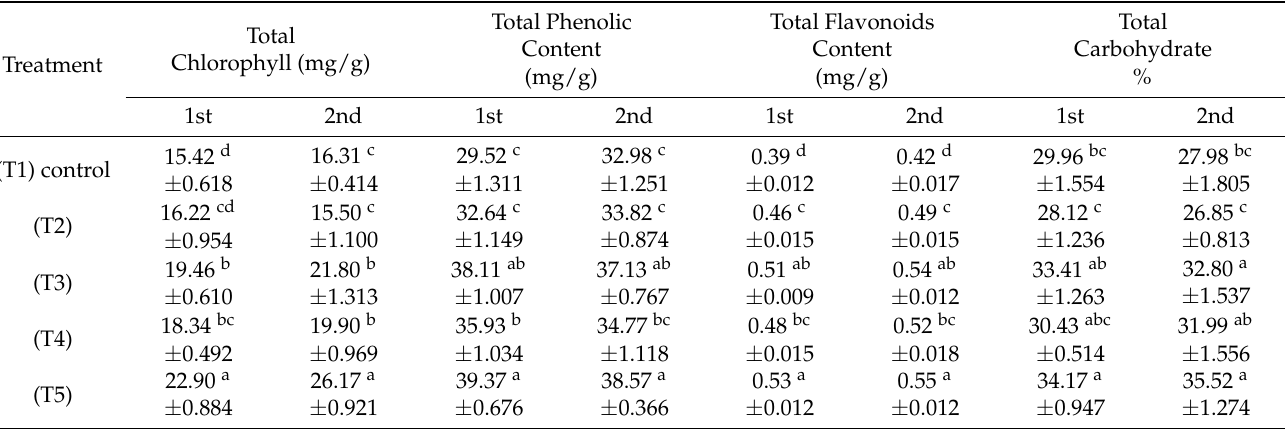
Table 6. Photosynthetic pigments and biochemical contents under drought conditions and different nanoparticle applications on Solidago canadensis plants during the 2020 and 2021 growing seasons.